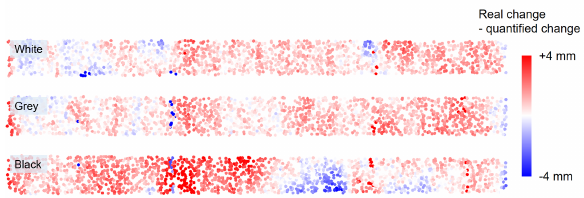
Table 4. Change detection metrics (completeness, correctness) for the standard M3C2 significance test and the one stemming from error propagation